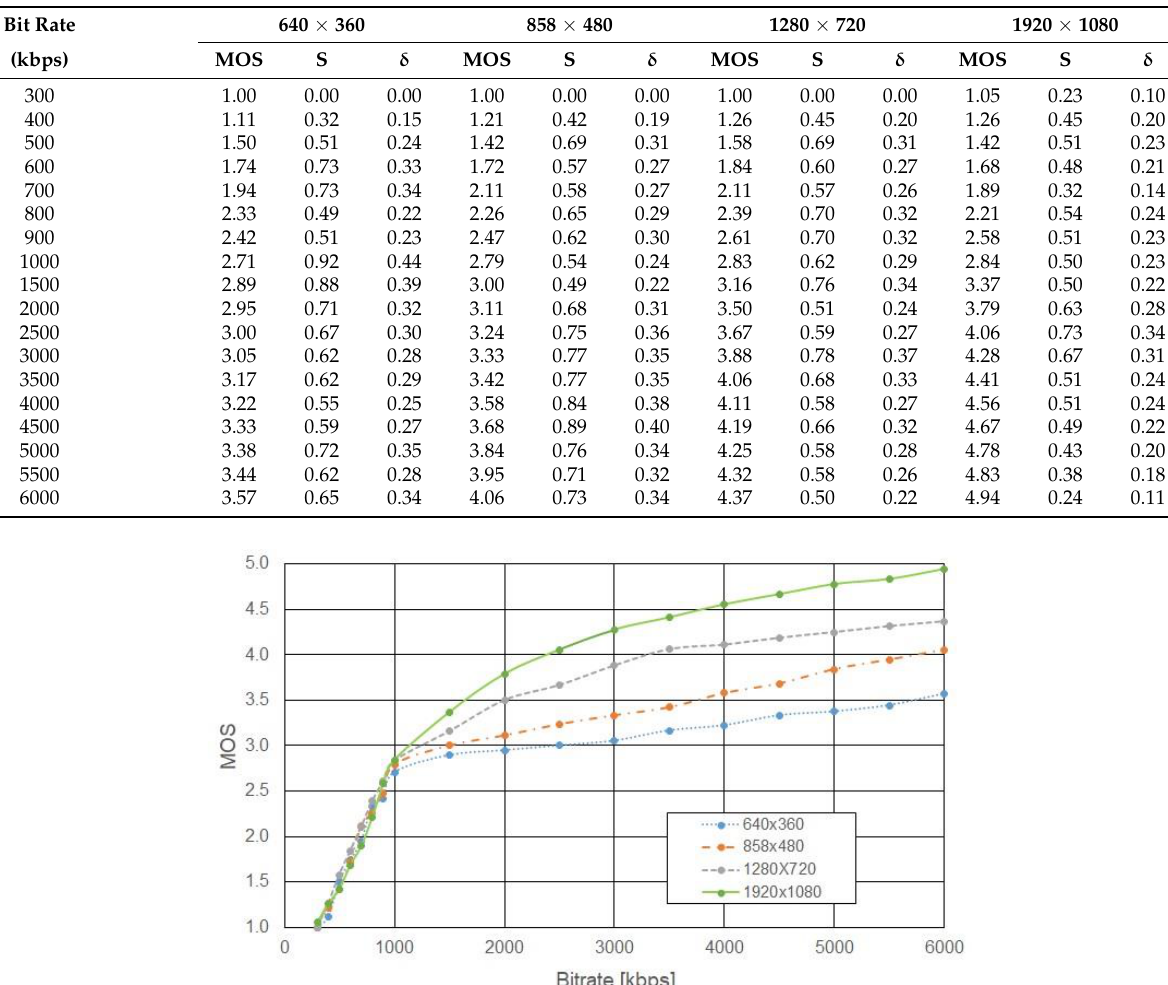
Table 2. Mean value of the video quality assessment (MOS) for H.264 codec, standard deviation (S), and confidence interval coefficient (δ) for four resolutions—measurements in laboratory.